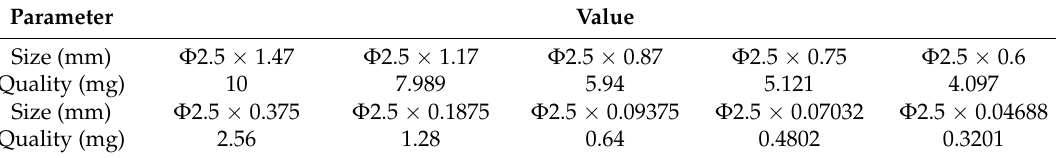
Table 3. Dimensions and corresponding quality parameter of the parameterized copper azide primer.